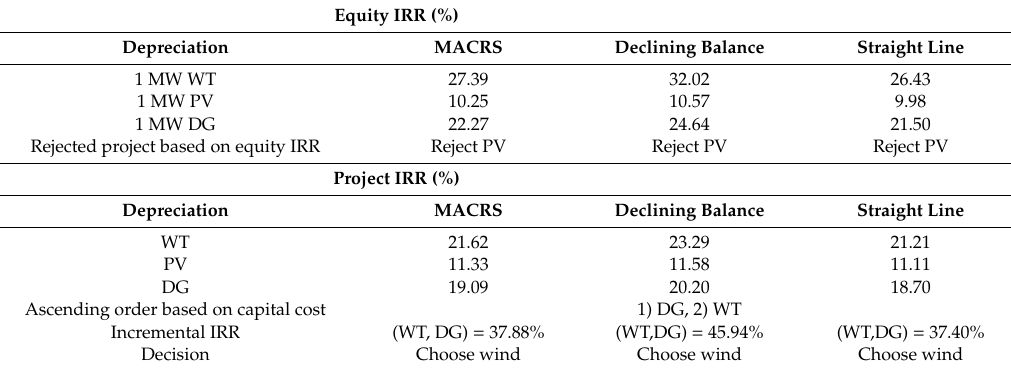
Table 3. Equity IRR and project IRR values of 1 MW